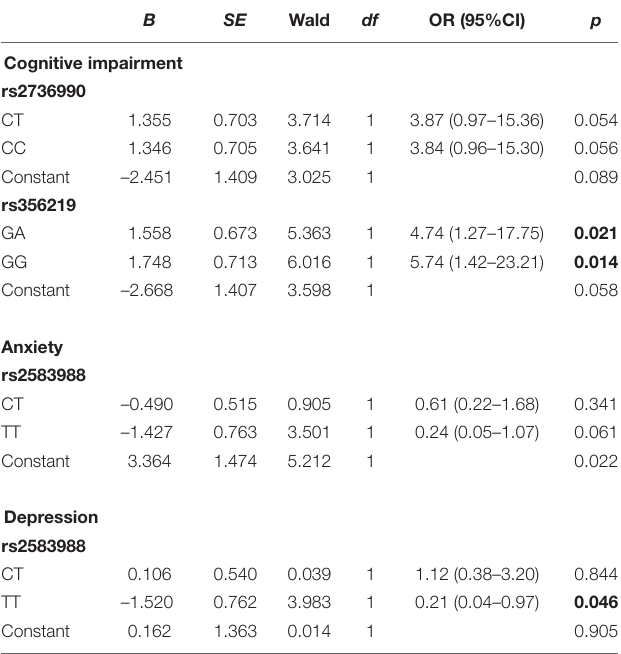
TABLE 5 | Binary logistic regression for risk genotypes predicting cognitive, anxiety, and depression in PD patients.